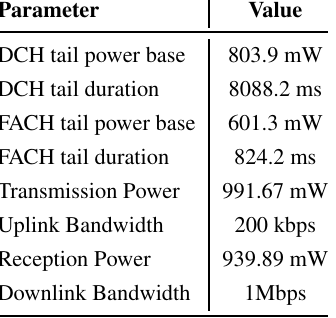
Table 1: Power Parameters for 3G Radio State